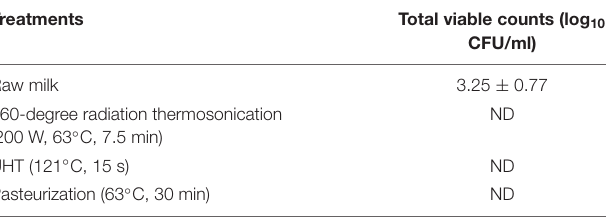
TABLE 3 | The total viable counts in milk before and after various treatments.